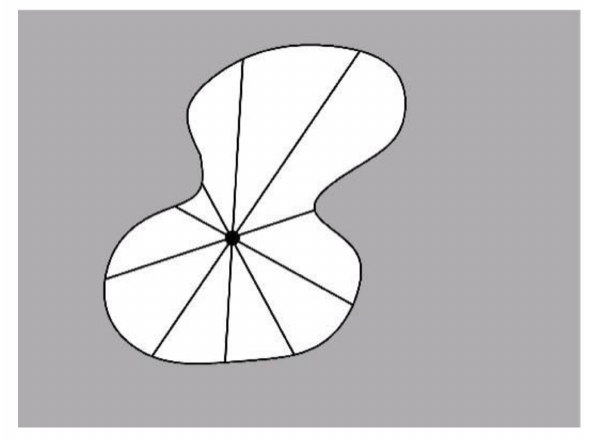
Figure 3. Average aperture collection